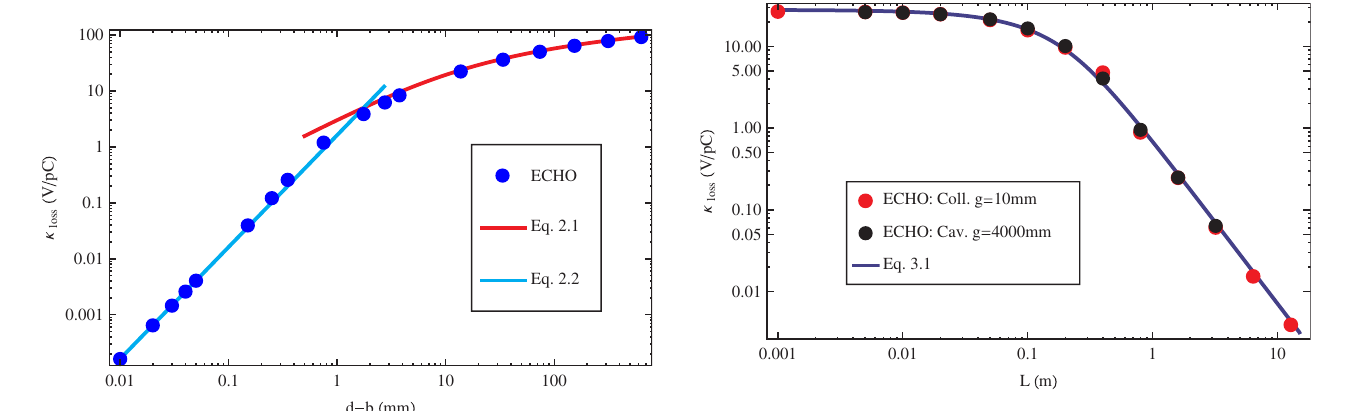
FIG. 10. (Color) We show the results of ECHO calculations of the loss factor as a function of taper length L for a tapered collimator with g ¼ 10 mm (red dots) and a tapered cavity with g ¼ 4000 mm (black dots). In both cases d ¼ 25 mm , b ¼ 6 : 25 mm , and (cid:1) ¼ 0 : 5 mm . The blue curve is given by Eq.